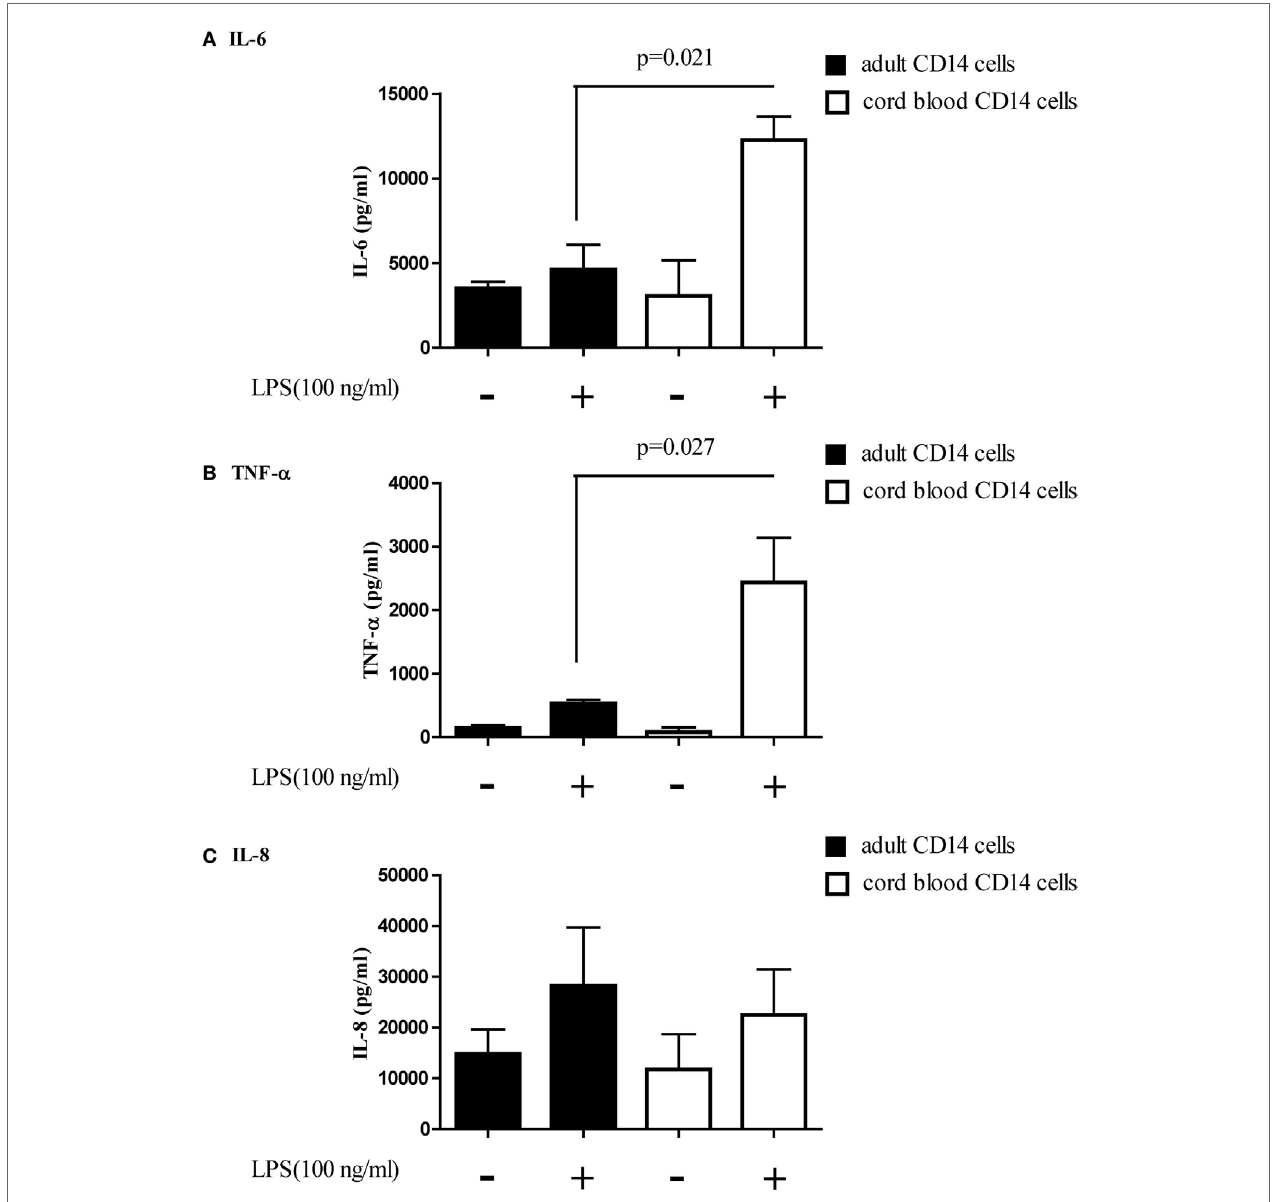
FigUre 12 | adult and cord blood (cB) monocytes produced large amounts of pro-inflammatory cytokines upon lPs stimulation . Adult and CB monocytes were stimulated with LPS for 16 h, and then the supernatant was collected for quantification of (a) interleukin (IL)-6, (B) IL-8, and (c) TNF- α secretion. * p < 0.05 between adult and CB monocytes with Mann–Whitney U test ( n =